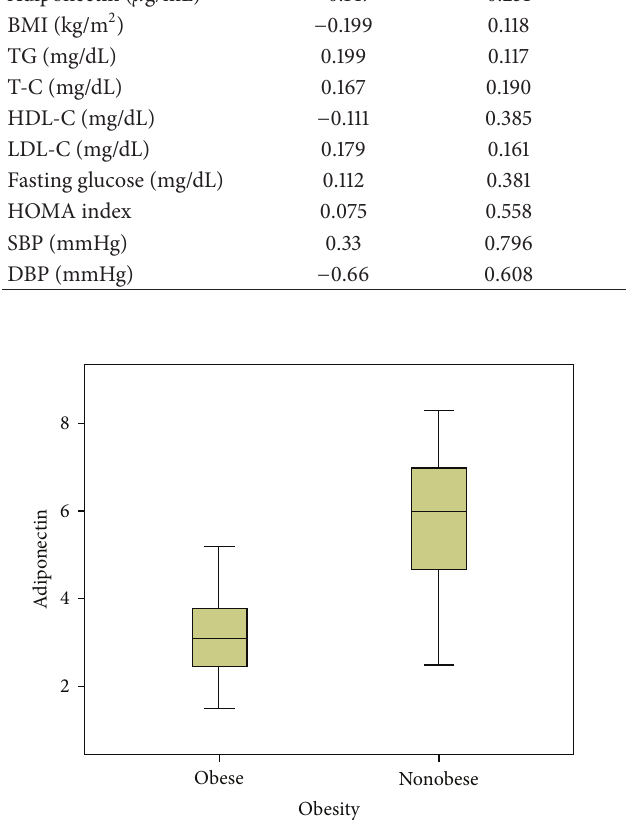
Figure 2: Serum adiponectin levels in obese and nonobese subjects.